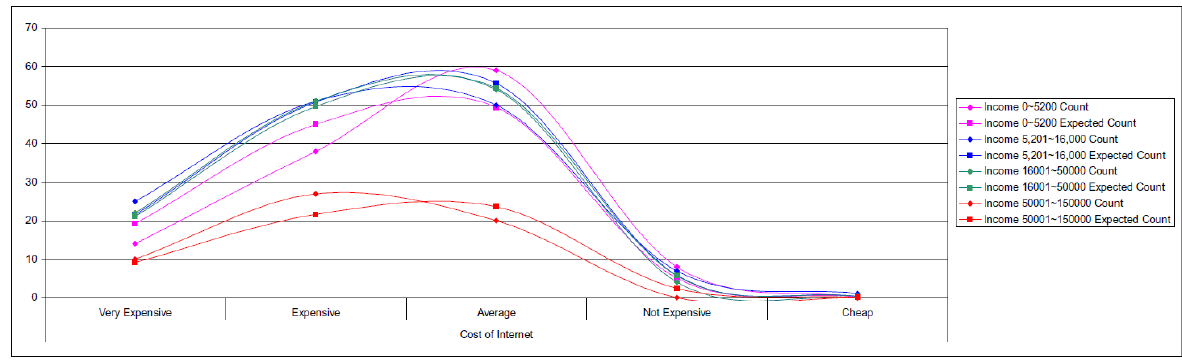
Figure 6: Cost of Internet Service by Socio-Economic Class (source: